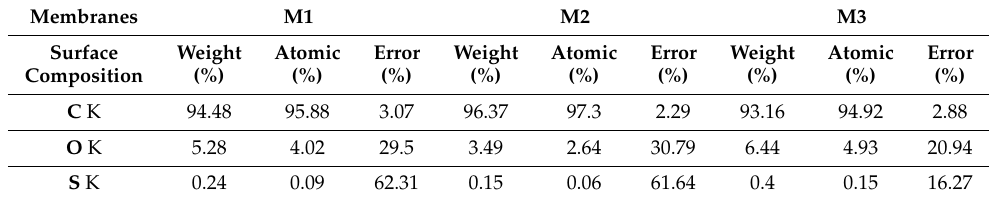
Table 3. Energy dispersive spectroscopy analysis (EDAX) for the prepared membranes. Membranes